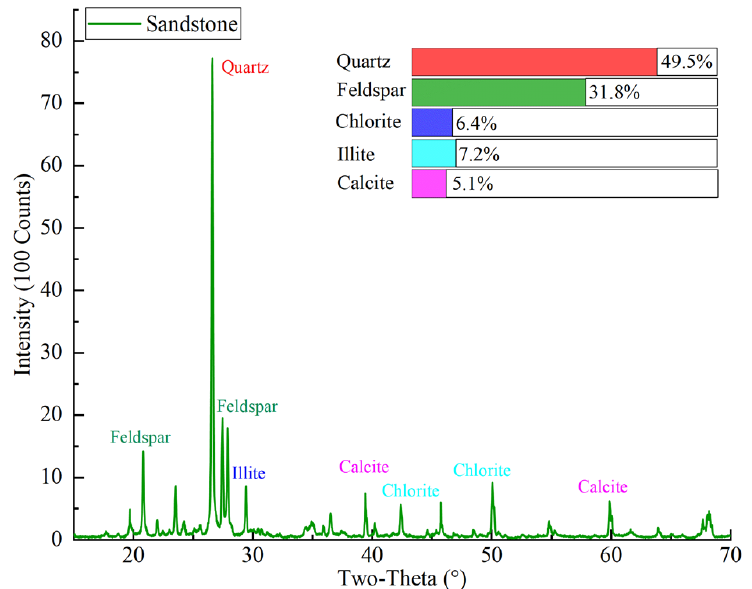
Figure 2. Results of X-ray diffraction test. Table 1. Mean values of physico-mechanical parameters of yellow sandstone.